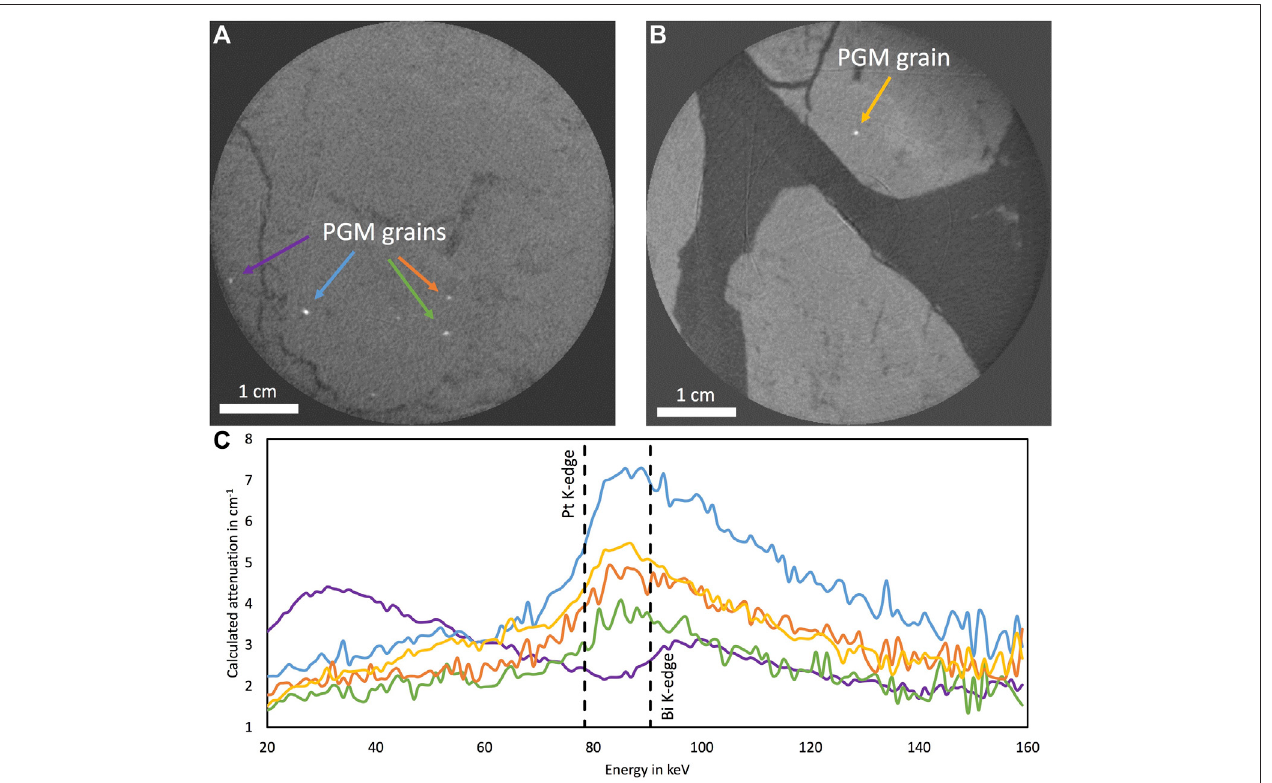
FIGURE 4 | (A) : Reconstructed sp-CT scan of sample RM2.10 VOI with different PGM grains; (B) : Reconstructed sp-CT scan of sample RM1.29 VOI with a PGM grain; (C) : Spectra of different PGM grains in the samples indicated with different colors and the K-edges of Pt and Bi.